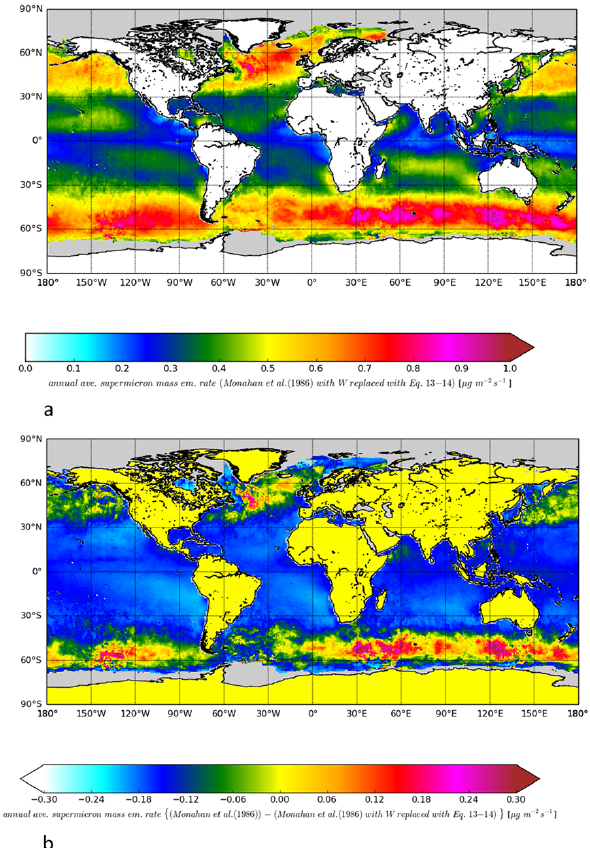
Figure 15. (a) Annual average super-micron mass emission rate for 2006 in µgm − 2 s − 1 calculated from Eq. 4 (cid:48) . (b) Difference map be- tween the annual average super-micron SSA mass emission rate calculated from the Monahan et al. (1986) SSSF and the annual average super-micron SSA mass emission rate calculated from the Monahan et al. (1986) SSSF where W is replaced with Eqs. (13)– (14). The calculations use wind speed U 10 from QuikSCAT in the whitecap